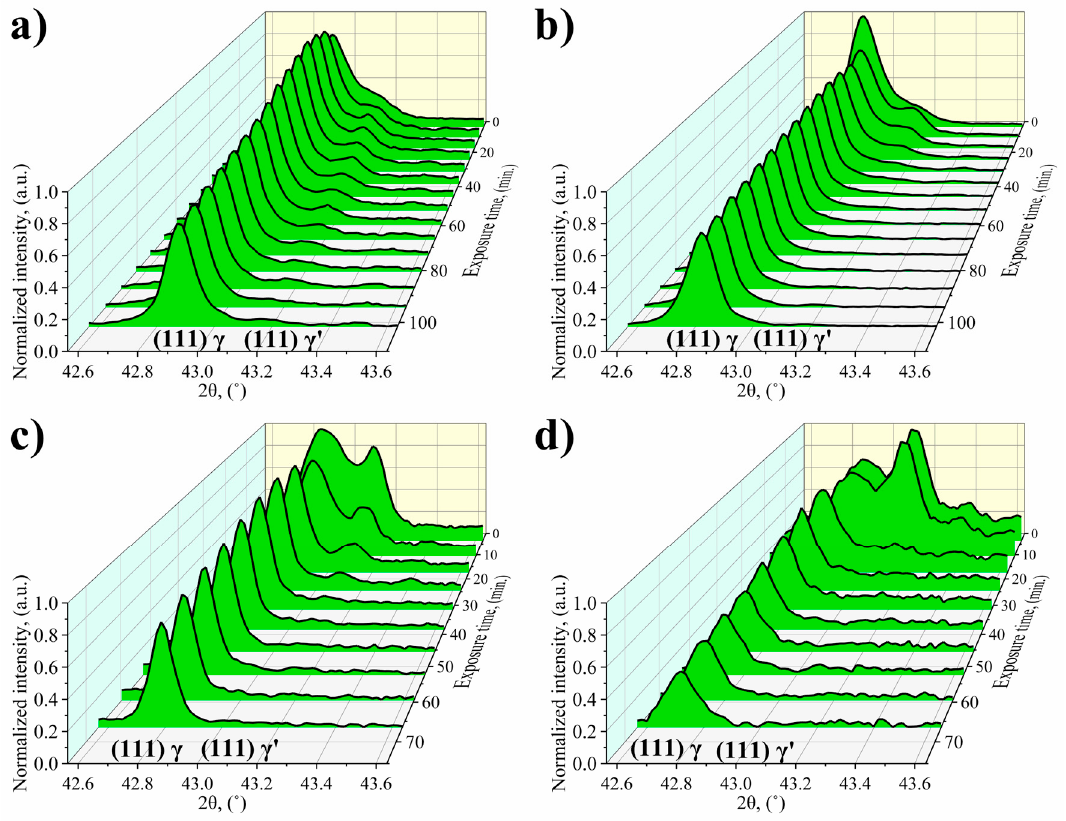
Figure 8. Normalised (111) peak shape evolution during exposure at: ( a ) 1100 °C; ( b ) 1150 °C; ( c ) 1200 °C; ( d ) 1250 °C.